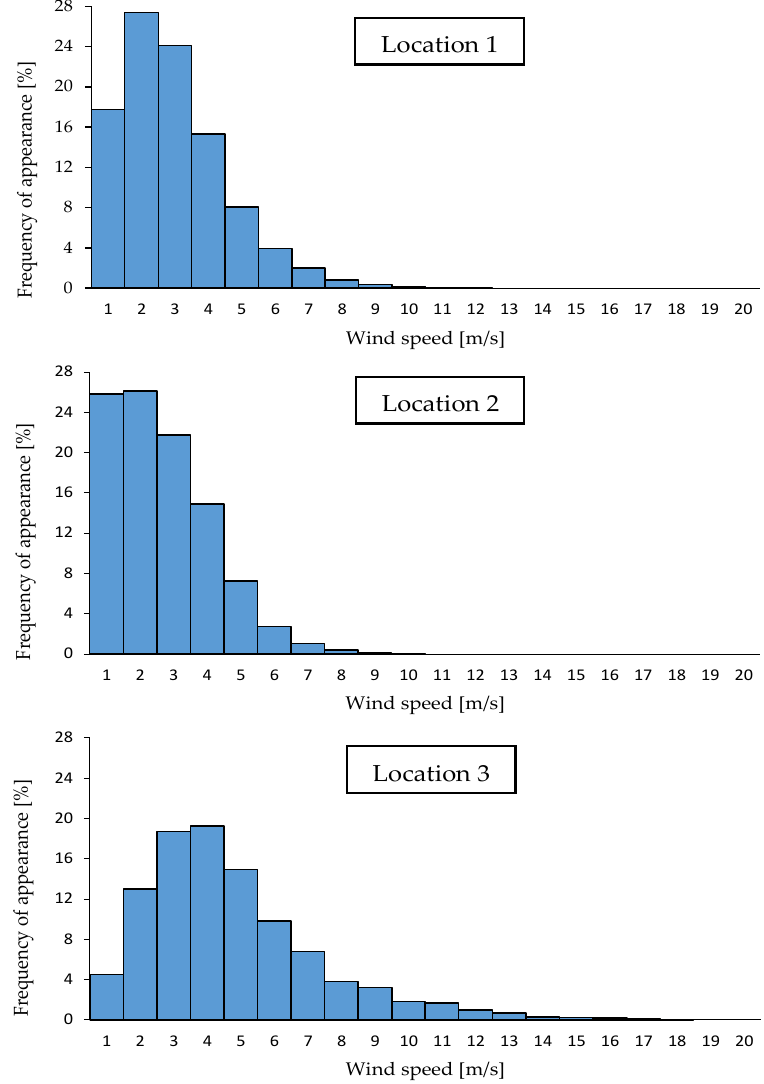
Figure 8. Wind speed distribution in 2018. Figure 9 shows the distribution of wind direction at the three locations in 2018. At Location 1, there were three dominant wind directions with similar frequencies of approxi- mately 11%: northwestern, eastern and southern. At Location 2, the wind directions were less diverse, with no wind direction exceeding 10%, but were most often from the north and southeast. At the coastal Location 3, the most frequent wind direction was southern, with a frequency of 14.62%, reflecting the strong influence of the sea breeze. The average annual wind speeds for each location are shown in Table 3 and Figure 10. At each